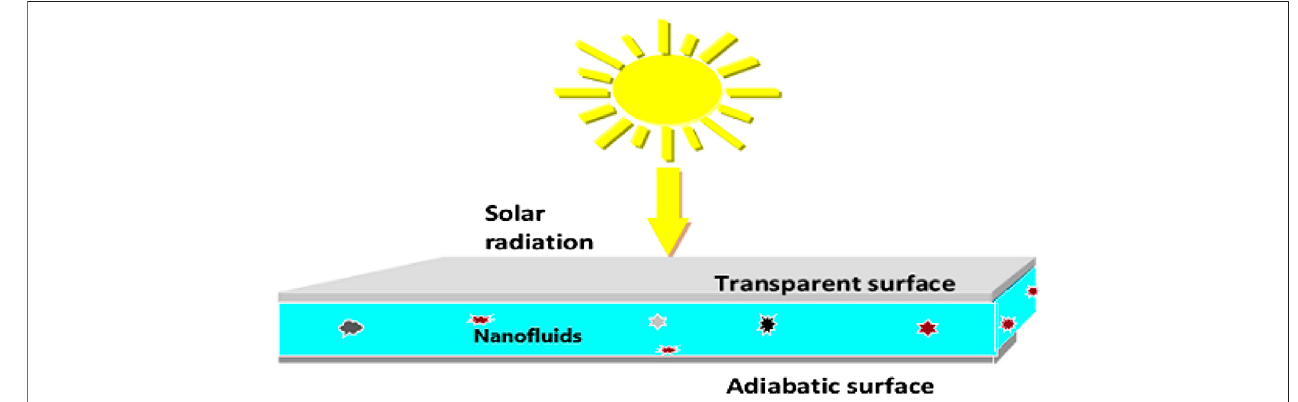
FIGURE 3 | Schematic diagram of a direct solar collector with nano fl uids (adapted from (Karami et al., 2014)).